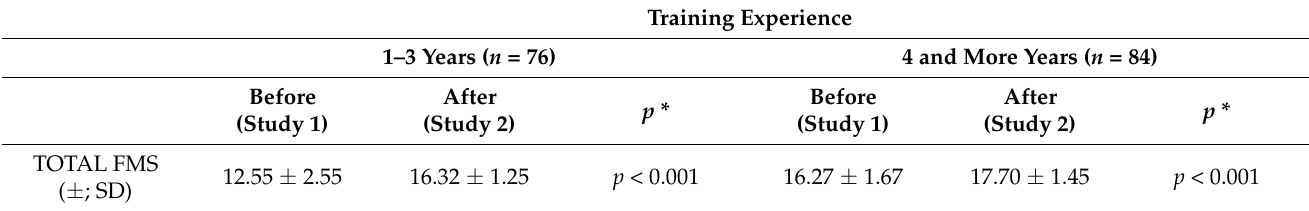
Table 5. FMS composite score before and after core stability training sorted by training experience. Training